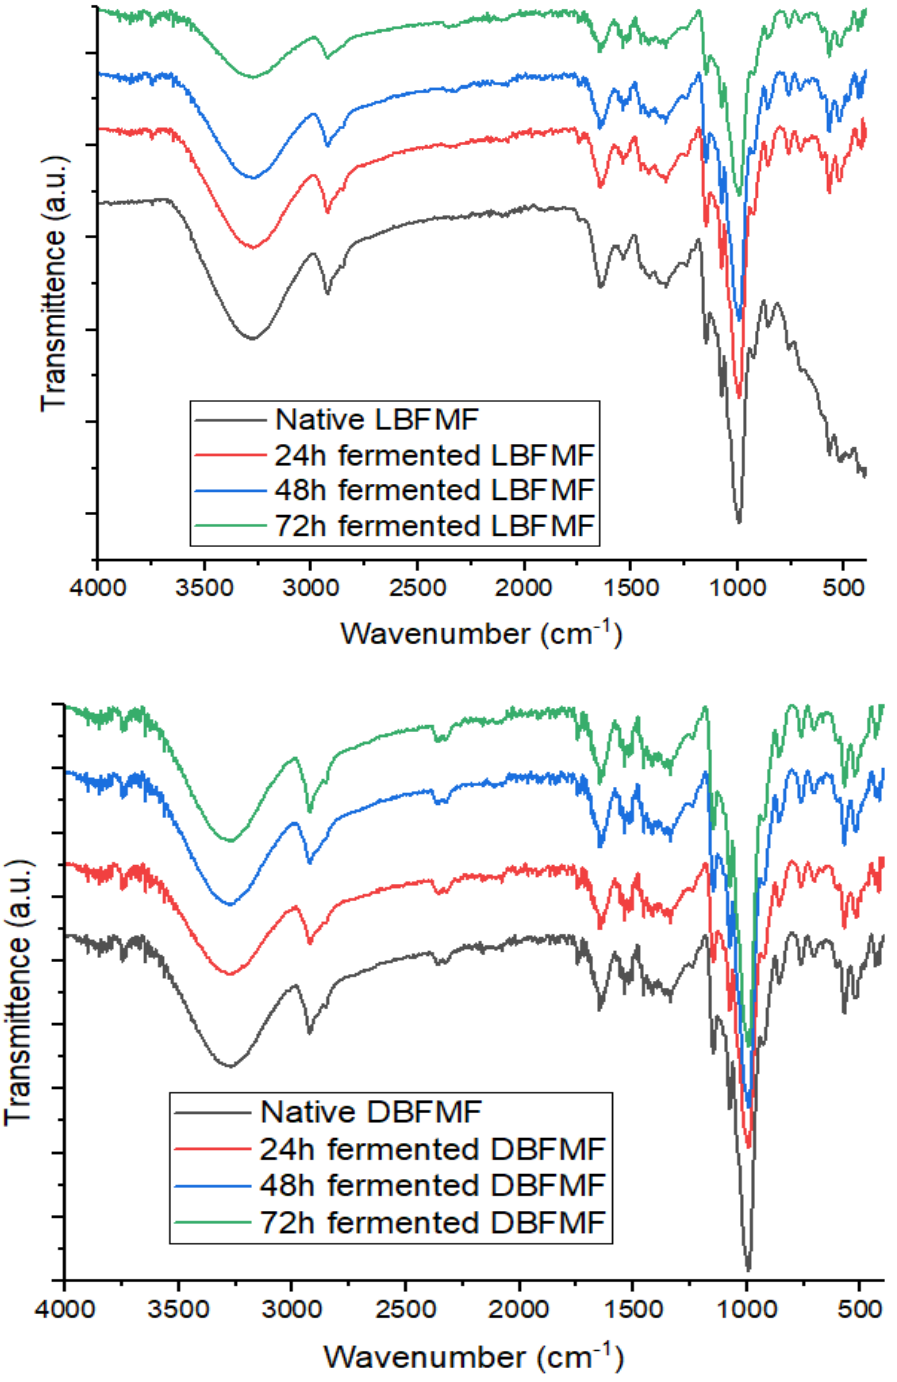
Figure 2. FTIR spectra of finger millet flours. LBFMF = light-brown fermented finger millet flours, DBFMF = dark-brown fermented finger millet flours.